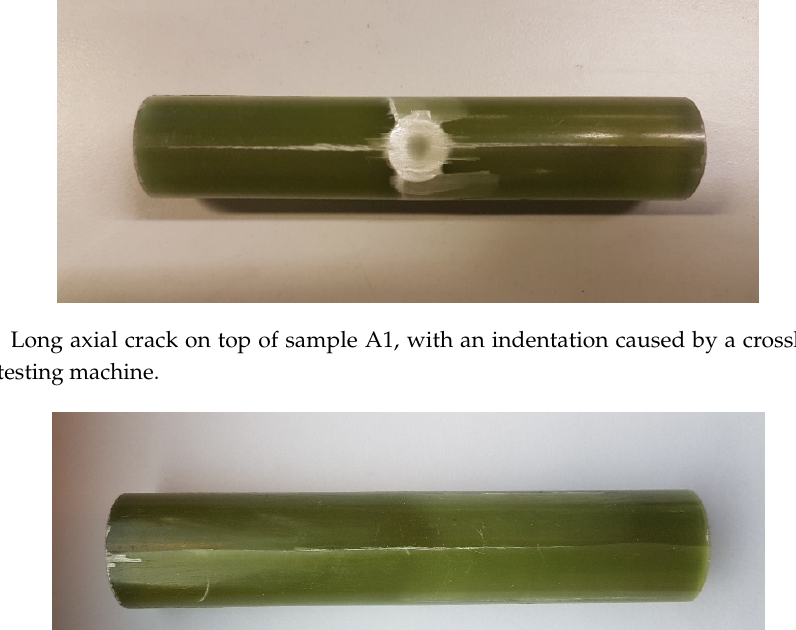
Figure 7. Mechanical characteristics of the 3-point bending test for samples subjected to high direct current (DC) voltage and temperature–group C.